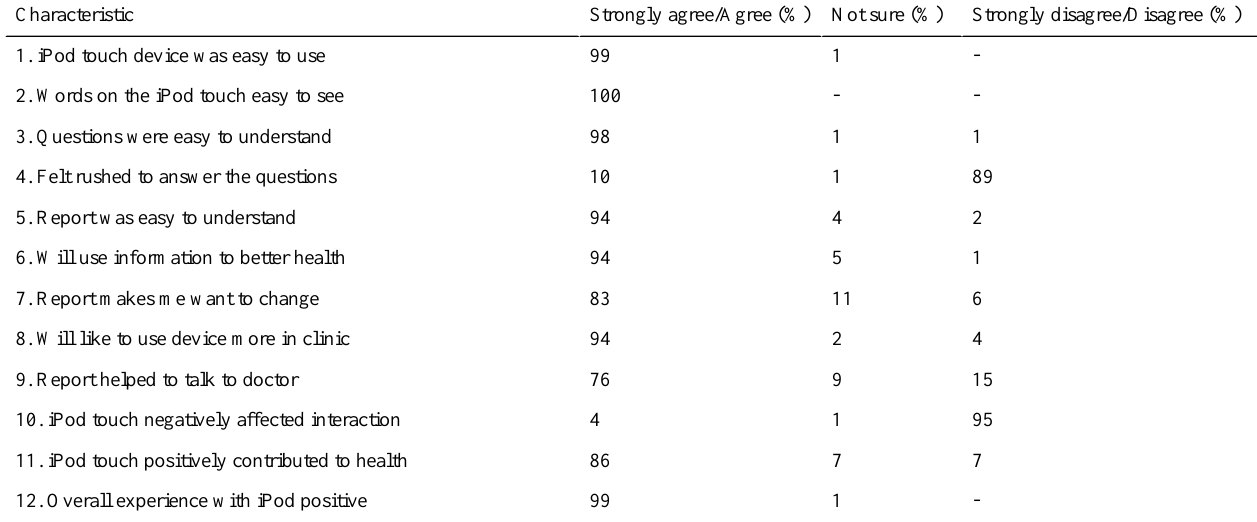
Table 4. Participants’responses to the follow-up phone survey (n=83) a